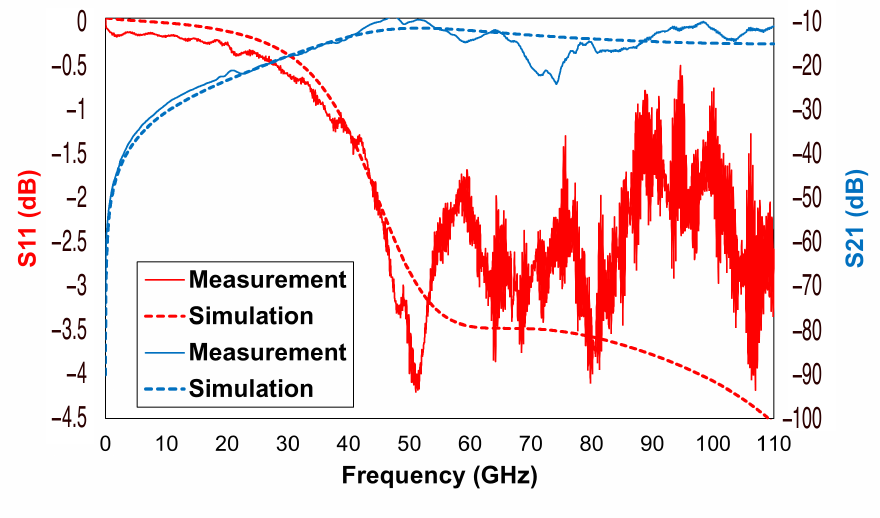
Figure 7. Comparison between the simulated and the measured electromagnetic characteristics of the discussed RF-MEMS switch in its OPEN